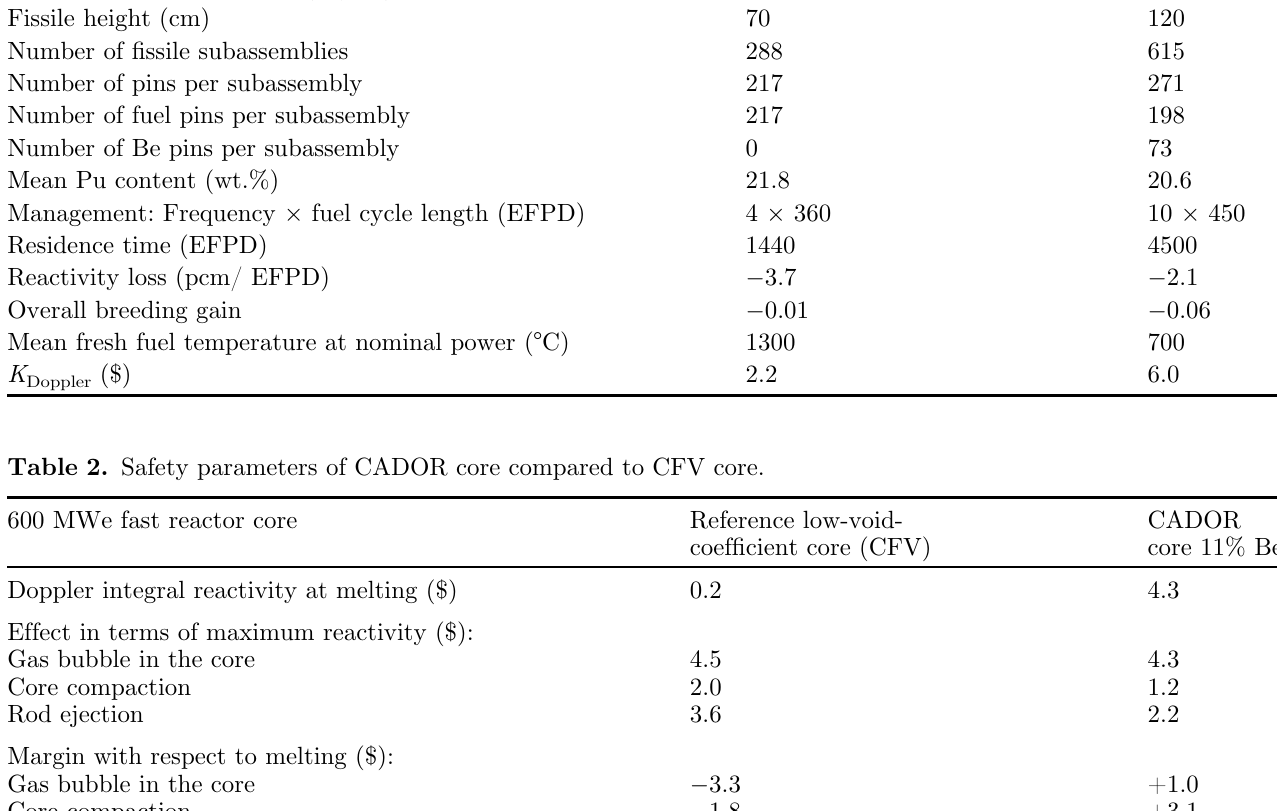
Mean Pu content (wt.%)